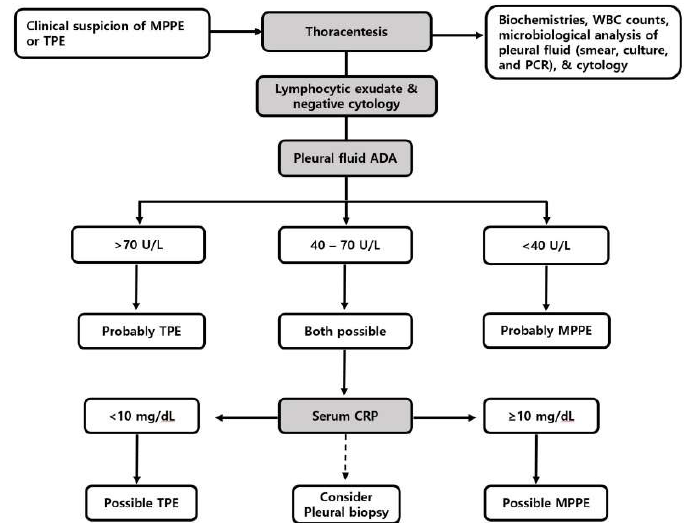
Figure 1. Proposed diagnostic algorithm for suspected patients with Mycoplasma pneumoniae parapneumonic effusion or tuberculous pleural effusion. MPPE = Mycoplasma pneumoniae parapneumonic effusion; TPE = tuberculous pleural effusion; WBC = white blood cell; PCR = polymerase chain reaction; ADA = adenosine deaminase; CRP = C-reactive protein.